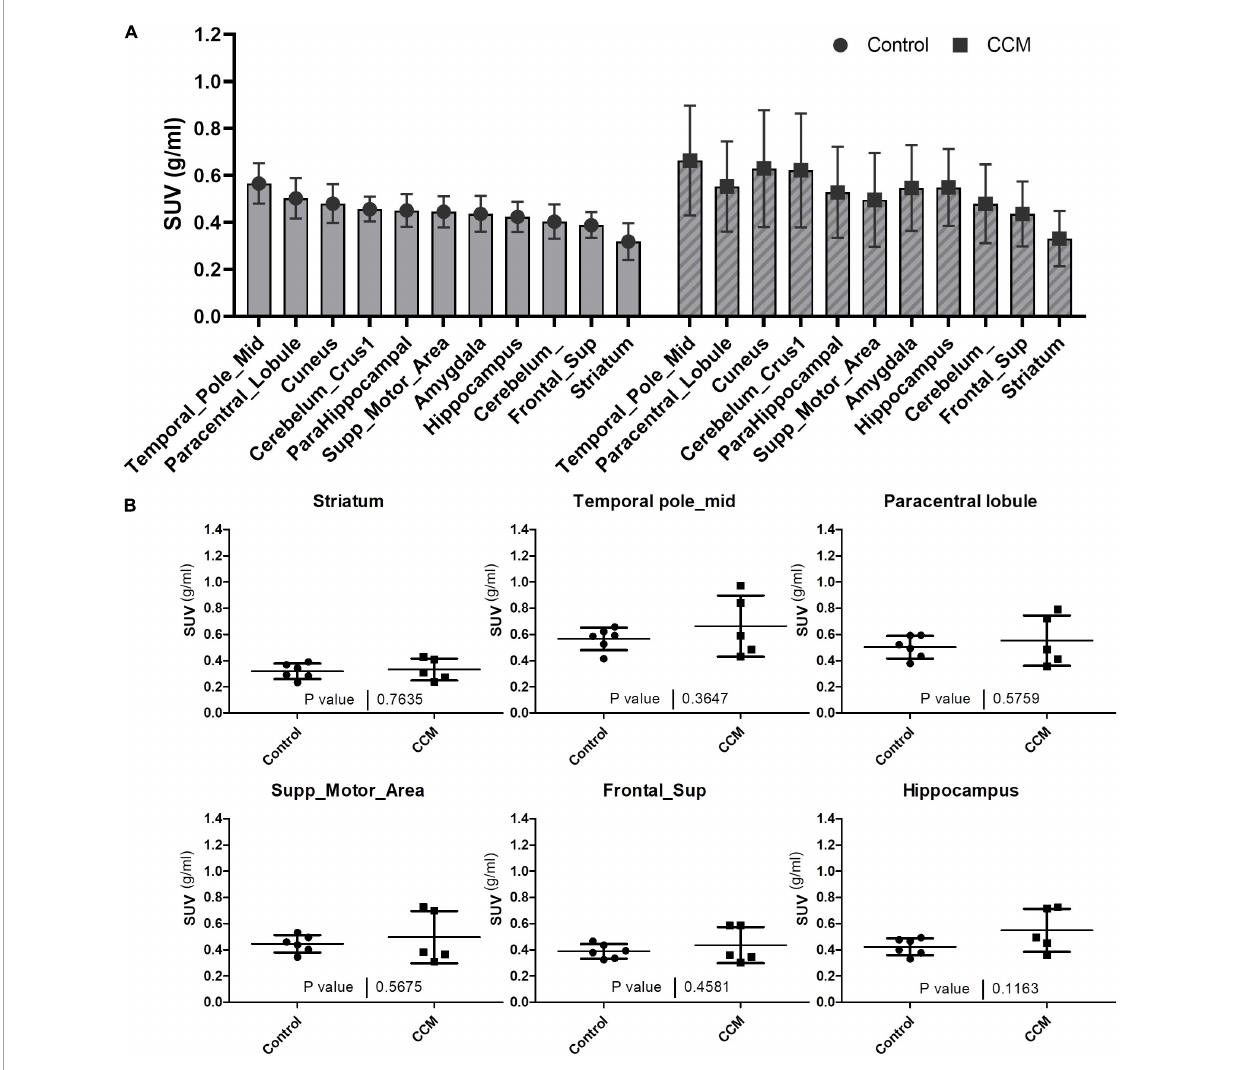
FIGURE1 (A) Average SUVs with standard deviation of global brain tissue flutriciclamide uptake in control (gray) and CCM groups (striped). The temporal pole indicates the highest uptake, and the striatum indicates the lowest uptake among all the brain tissue regions. (B) Comparison of flutriciclamide uptake in representative brain tissue of control and CCM groups. The AAL template was used as a predefined ROI. P <